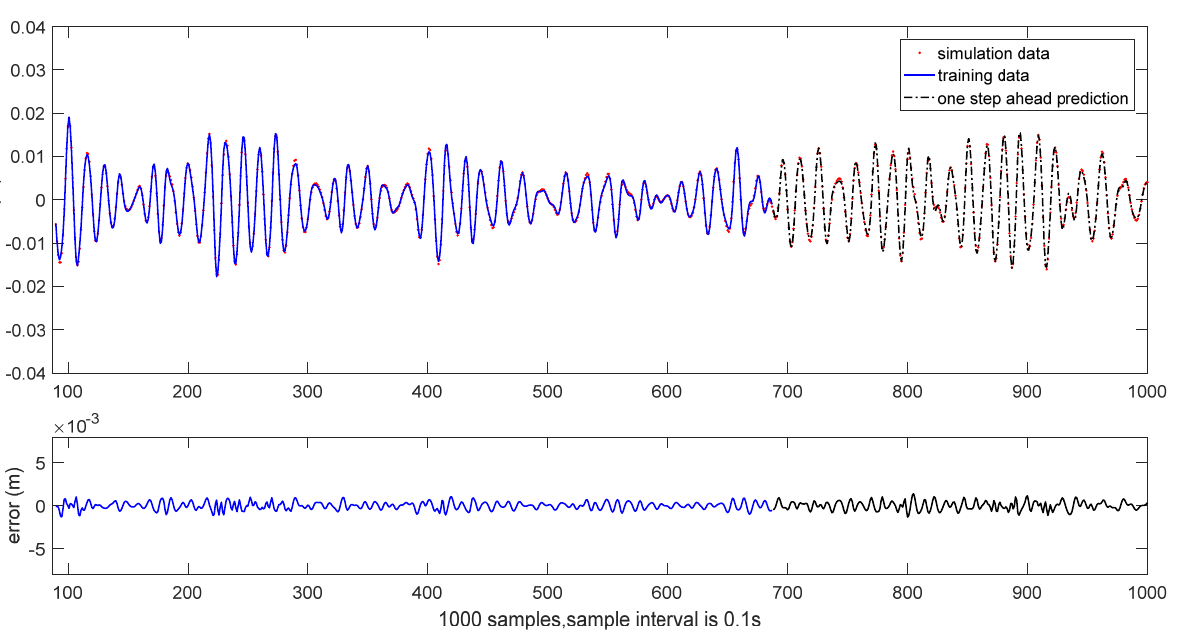
Figure 8. The one-step-ahead prediction of heave motion in irregular waves at the instant k = 687 for the R-Class Icebreaker model.